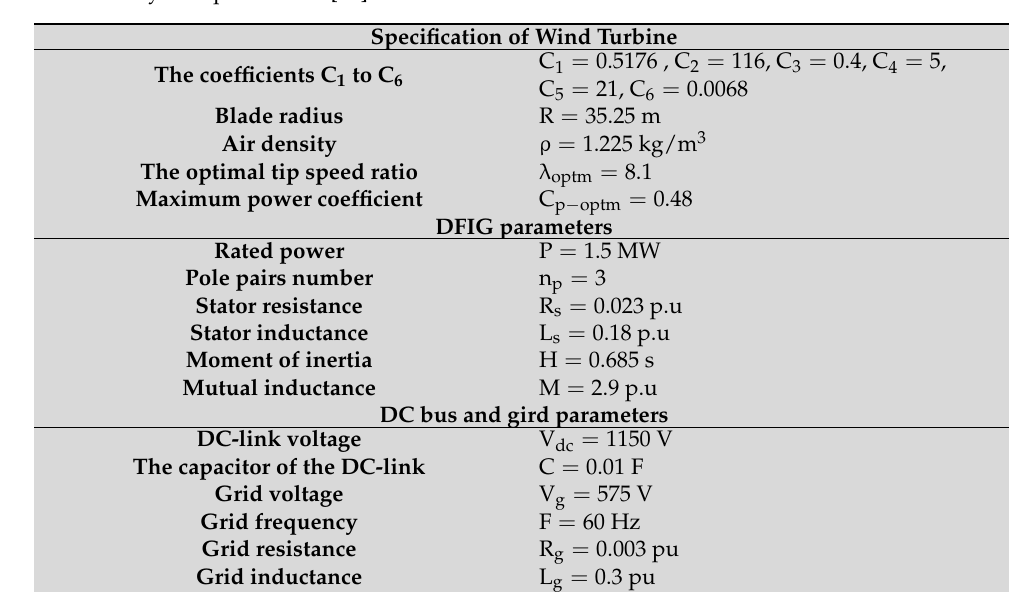
Table A1. System parameters